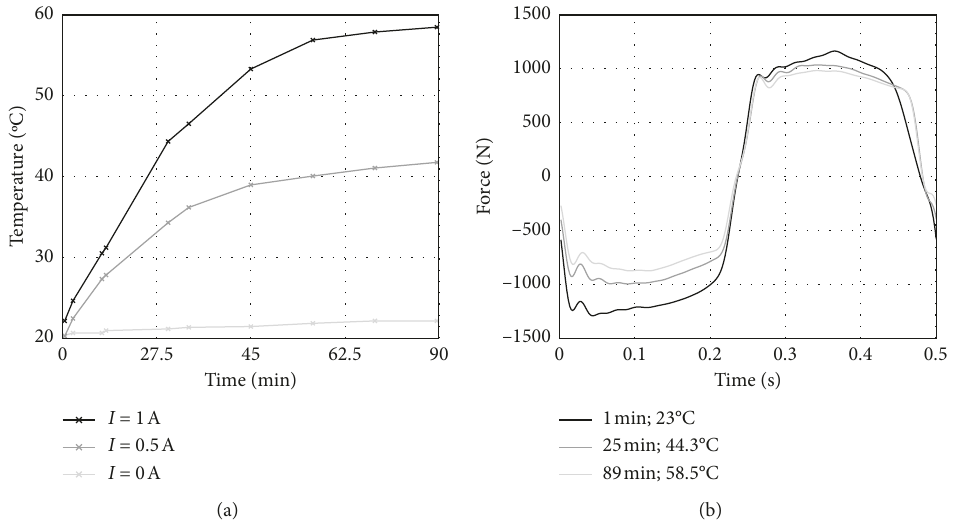
Figure 1: (a) Time response of the MR damper body temperature for three different currents (0, 0.5, and 1A) and (b) sample of a damper force cycle with a constant current of 1 A after different elapsed times (1, 25, and 90 minutes). In both cases, the excitation is a sinusoidal excitation of 8 mm amplitude and 2 Hz frequency.